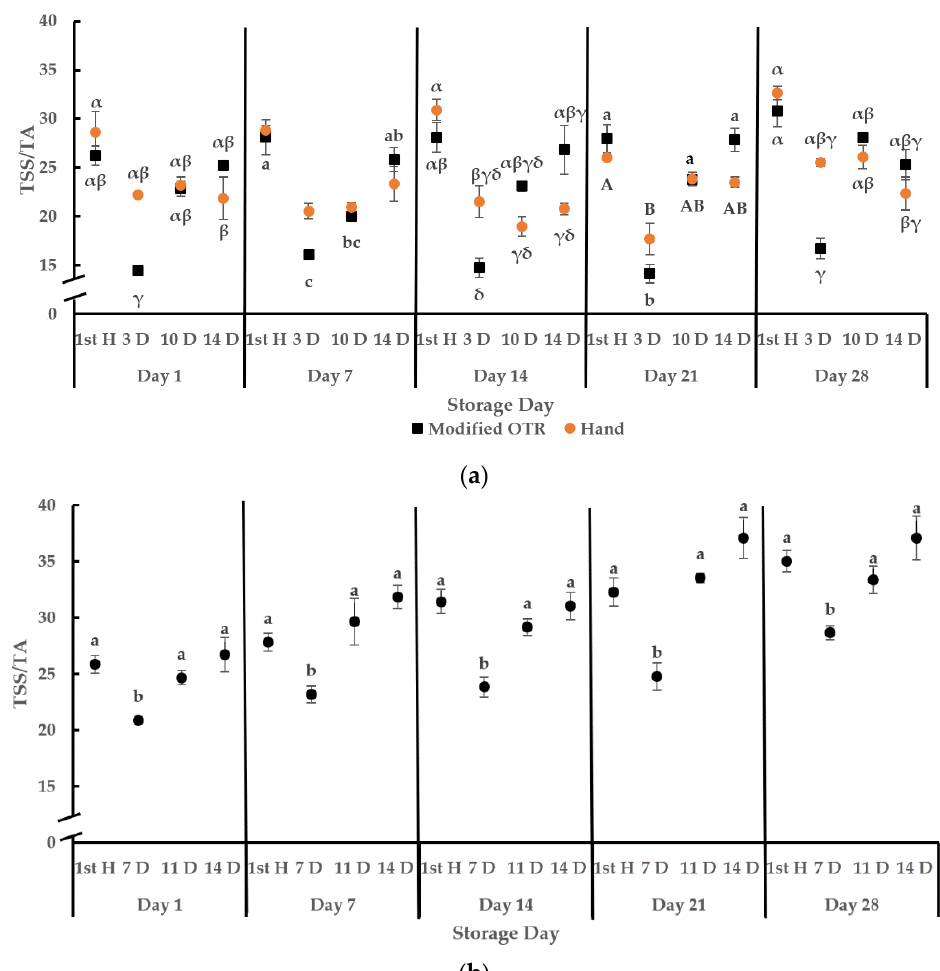
Figure 7. The ratio of total soluble solids (TSS) over titratable acidity (TA) of ‘Liberty’ northern highbush blueberry in 2019 ( a ) and 2020 ( b ) at 1, 7, 14, 21, and 28 days after packing. Fruits were harvested at 3-, 10-, and 14-day harvest intervals in 2019 and at 7-, 11-, and 14-day harvest intervals in 2020. The first harvest was the baseline from which interval treatments were established. Fruits were harvested by hand or using a modified over-the-row (OTR) harvester with patent-pending elastomeric polymers installed on catching surfaces in northwest Washington, USA. Values are mean ± SE ( N = 6). Different lowercase letters indicate significant differences ( p < 0.05) due to intervals on each evaluation day. Different uppercase letters indicate significant differences ( p < 0.05) within hand-harvested fruits on each evaluation day due to harvest interval effect. Different Greek letters indicate significant differences ( p < 0.05) among both hand- and machine-harvested fruit on each evaluation day due to interaction effects of harvest method and interval. Hand and machine harvesting data are combined due to lack of harvest method and interaction effects in 2020 ( b ).